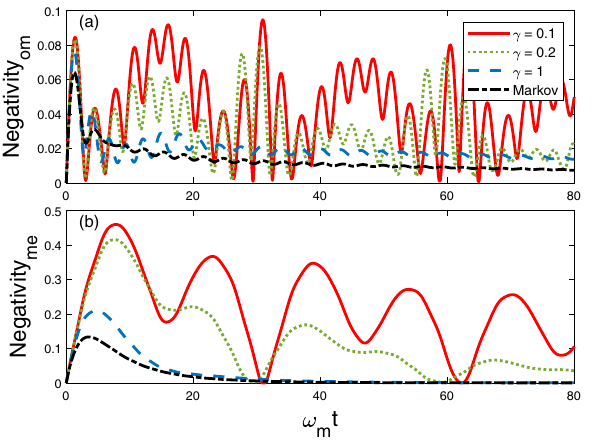
Figure 4. Dynamics of entanglement between OM and ME components for different decay factor γ . Other parameters are chosen as ω o = ω e = ω m , g om = g me = 0.1 ω m , Ŵ = 1 .